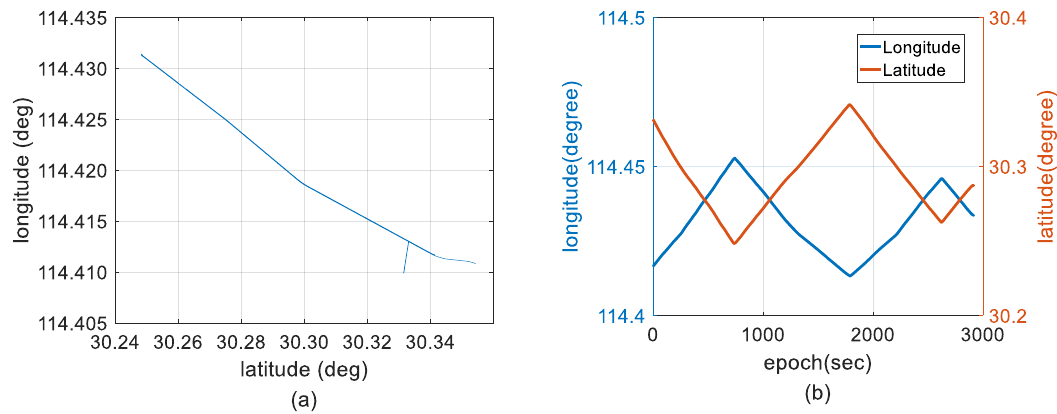
Figure 4. Reference trajectory. ( a ) Reference trajectory of dual-frequency ambiguity-fixed GPS/BDS/INS integration solutions processed by a backward filter with off-line Rauch – Tung – Striebel (RTS) optimal smoothing algorithm; and ( b ) reference longitude and latitude distributions for the whole duration.